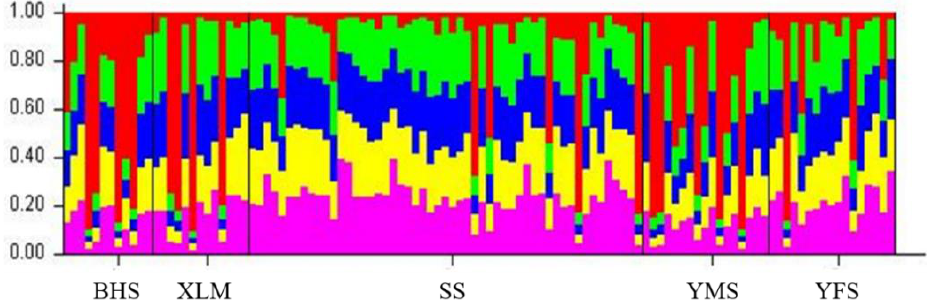
Figure 2. Genetic structure based on microsatellite genotypes in leopard cat subpopulations in the five sampling areas (k = 5). BHS represents Baihuashan in red, XLM represents Xiaolongmen in yellow, SS represents Songshan in green, YMS represents Yunmengshan in magenta, and YFS represents Yunfengshan in blue.